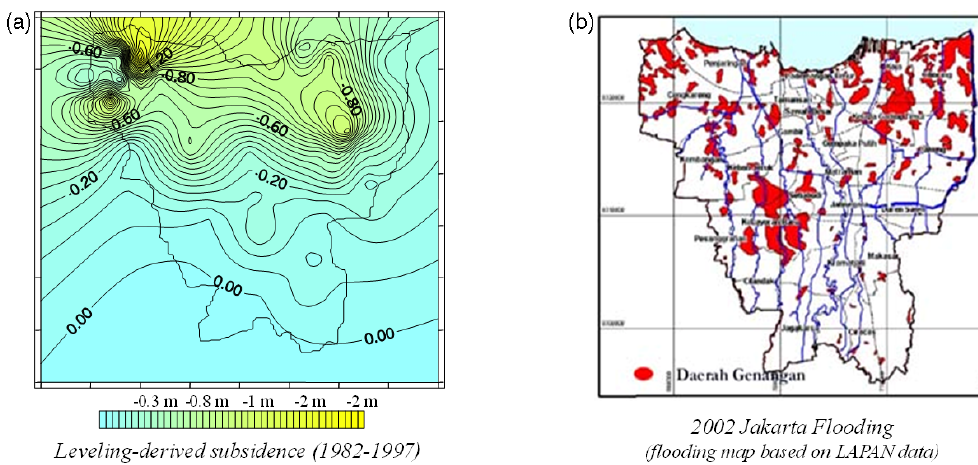
Figure 5. Spatial correlation between leveling-derived land subsidence (1982–1997) and flooding area in Jakarta (2002).